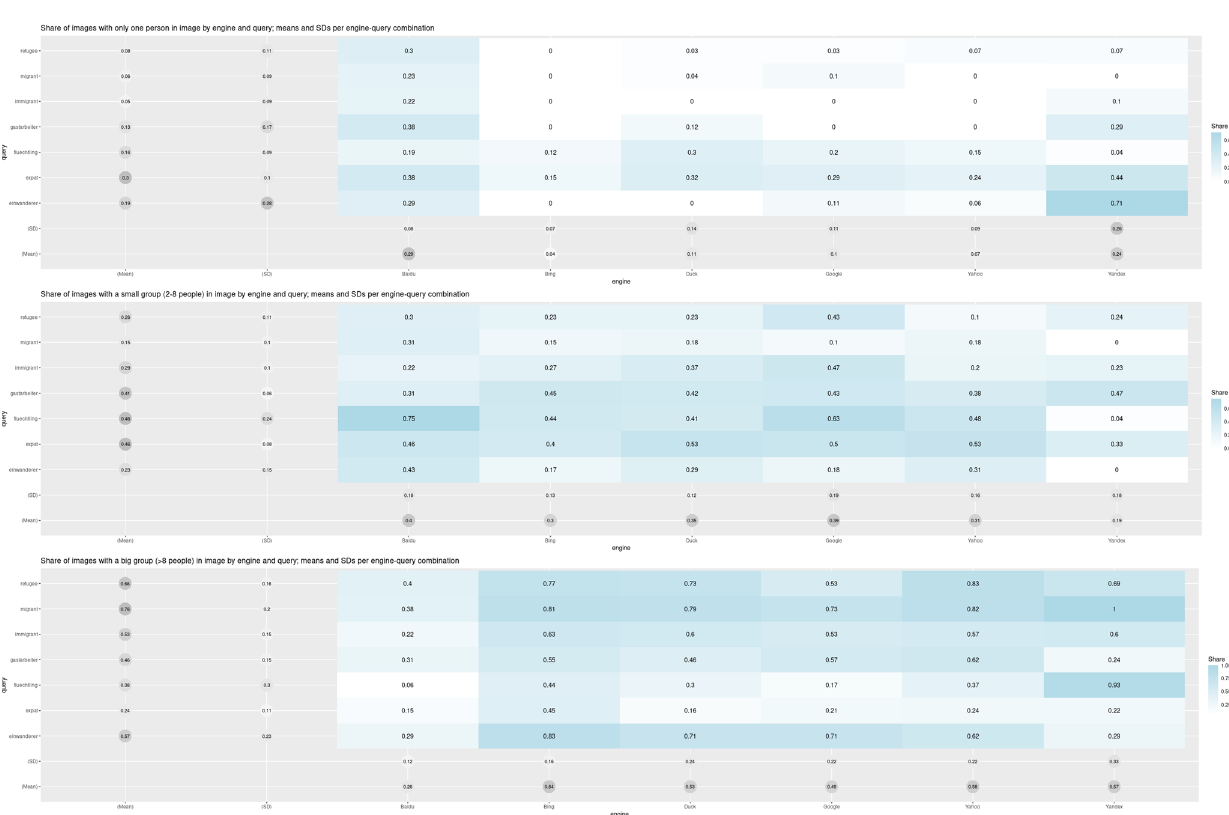
Fig. 3 Shares of images with individuals/small groups/big groups. Share of images with with individuals/small groups/big groups by search engine and